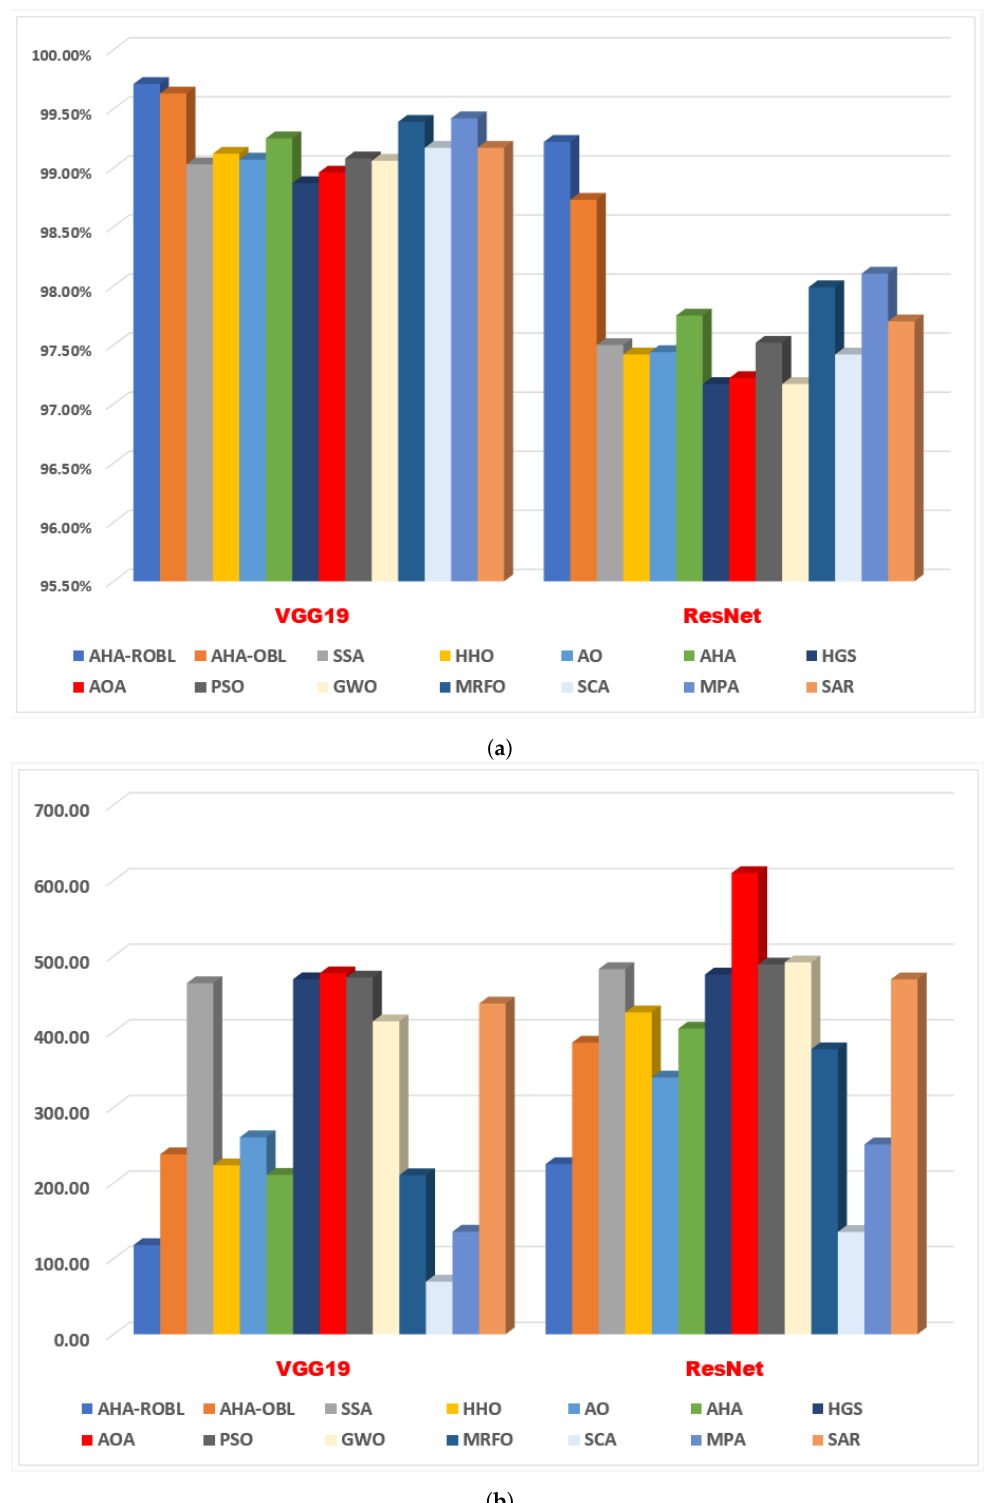
Figure 11. ( a ) Avg. specificity of the proposed approaches versus other algorithms using VGG19 and ResNet20 and ( b ) avg. execution time of the proposed approaches versus other algorithms using VGG19 and